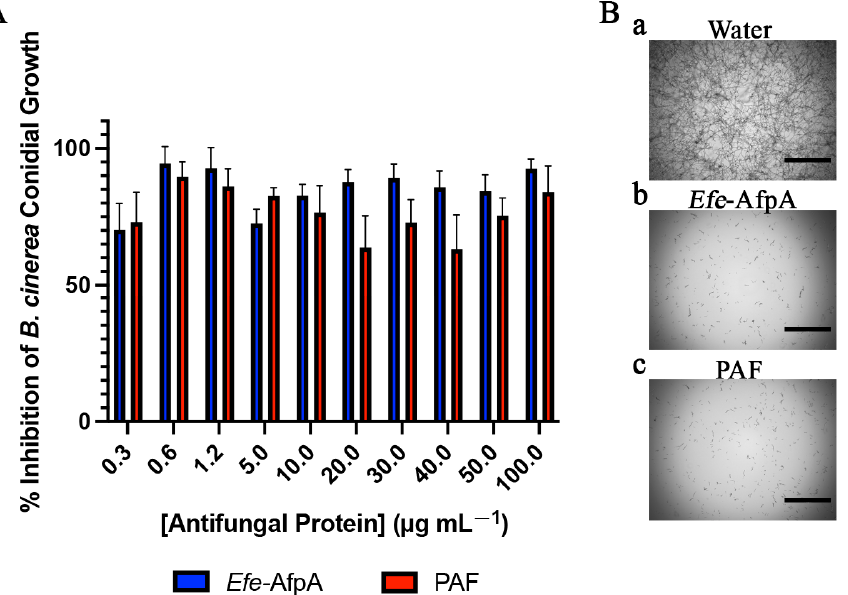
Figure 1. Activity of Efe -AfpA and PAF against B. cinerea conidial growth. ( A ). Growth inhibition of B. cinerea conidia treated with increasing concentrations of either Efe -AfpA or PAF incubated at room temperature for 30 h. The data presented are the means and standard deviations of three replicates. ( B ) Microscopy of B. cinerea conidia treated with water or 0.6 μ g mL − 1 of either Efe -AfpA or PAF. Bars are 750 μ m. Table 1. Minimal and maximum inhibitory concentrations of Efe -AfpA and PAF against fungal plant pathogens.